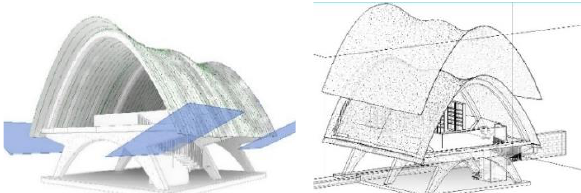
Figure 15. The surfaces of the roof membrane and the concrete shell are given thickness. Modeling them separately allows for exploded axo. diagrams and further studies of each component separately. (Drawn by Rajabzadeh,